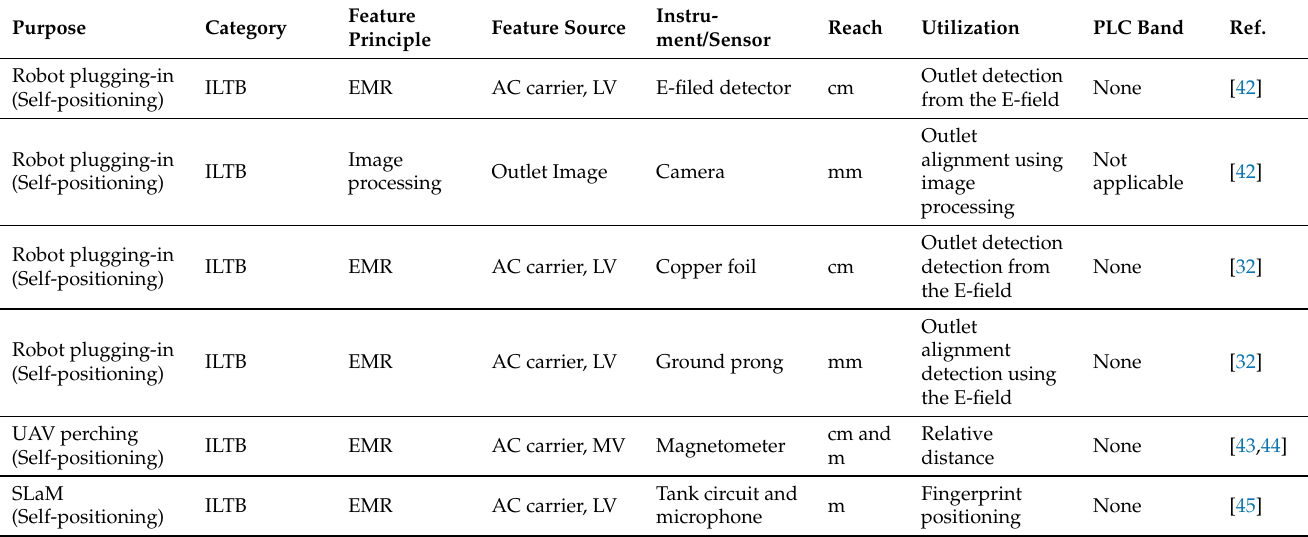
Table 2. List of PLPS and experiments with results indicating possibilities for PLC-IPS